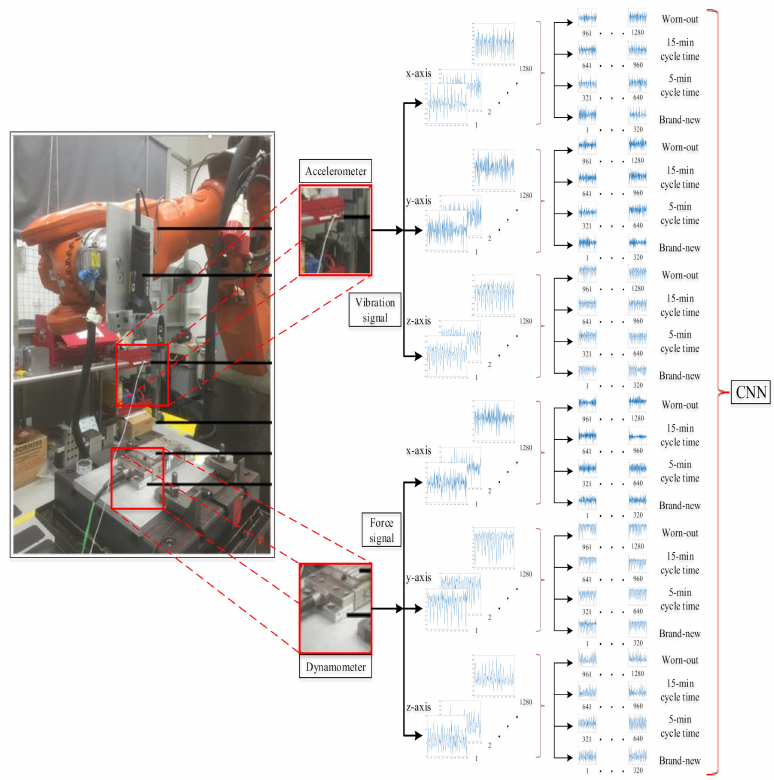
Figure 18. Data input preparation for CNN algorithm. The data consist of 3-axes vibration and 3-axes force